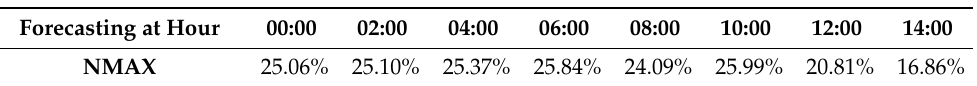
Figure 3. Solar irradiance forecasted profiles during a sample day, starting at successive two-hour intervals. Table 3. Error metrics for solar irradiance forecasting starting at successive two-hour intervals for a sample